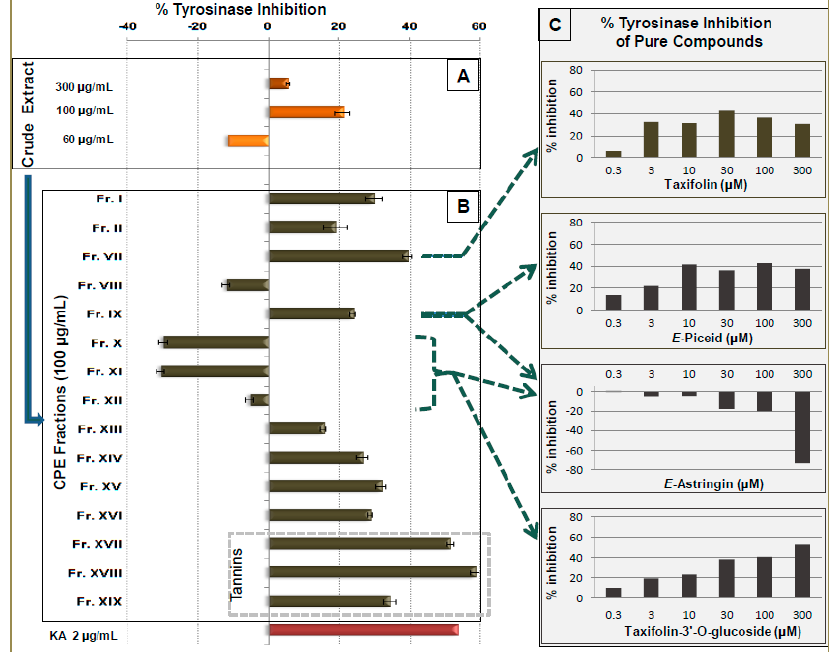
Figure 3. Tyrosinase inhibition activity of methanol bark extract, CPC fractions and pure compounds. ( A ) % inhibition activity of crude extract at 300, 100 and 60 μ g/mL , ( B ) % inhibition activity of CPC fractions at 100 μ g/mL and ( C ) % inhibition activity of pure taxifolin, E -piceid, E -astringin and taxifolin-3 ′ - O -glucoside in six concentrations (0.3, 3,10, 30, 100 and 300 μ M). Positive control: Kojic Acid (KA) at 2.0 μ g/mL.